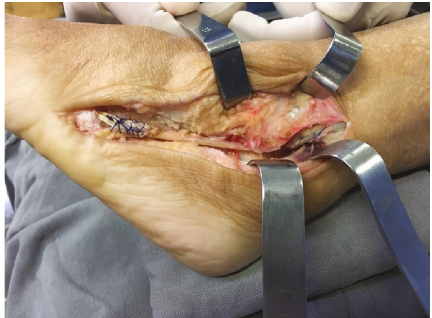
Figure 8: Patient II: bone-to-tendon fi xation distal through the bone tunnel after the removal of the remaining portion of the STA.